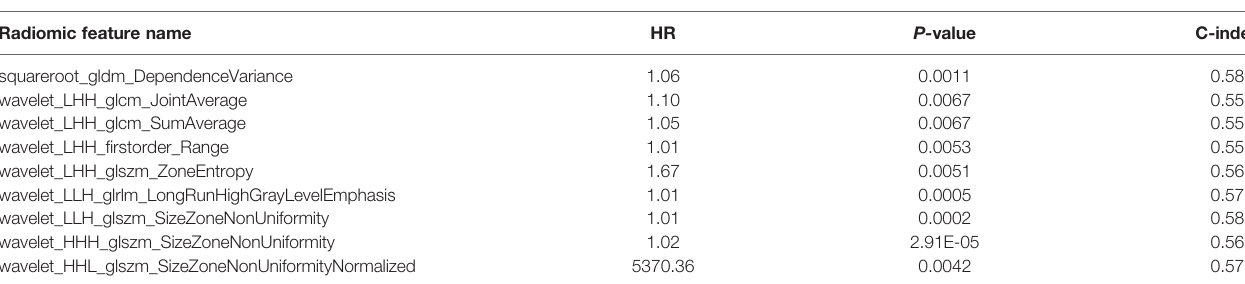
TABLE 2 | Composition of